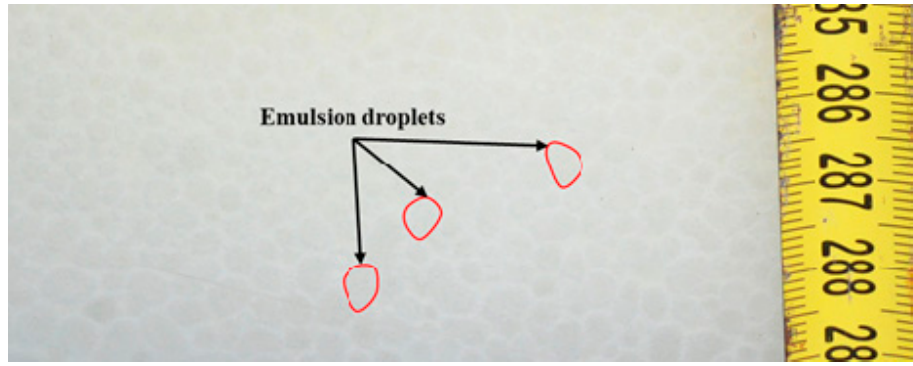
Figure 7. Emulsion droplets in the water–oil physical simulation experiment.